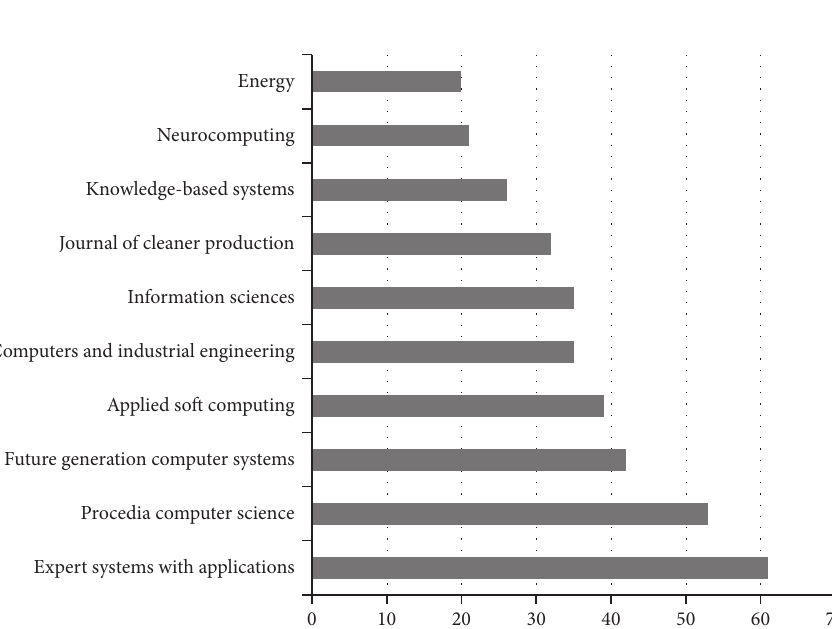
Figure 9: Article types with the number of